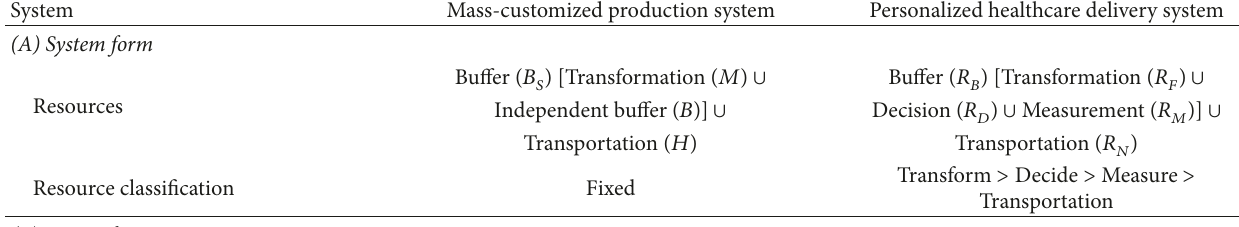
Table 3: Summary of the analogy between mass-customized productions systems and personalized healthcare